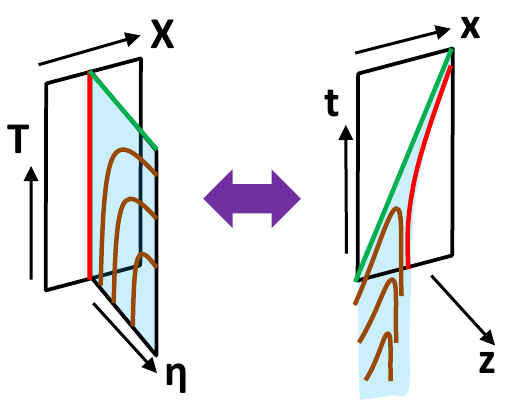
Figure 18 . Sketch of the transformation of EOW brane from Poincaré AdS 3 (left) to the gravity dual of type C and C moving mirror (right). The red curve (right) is the mirror trajectory mapped − 0 to the red, straight line in the left figure. The EOW branes correspond to the blue-colored regions.